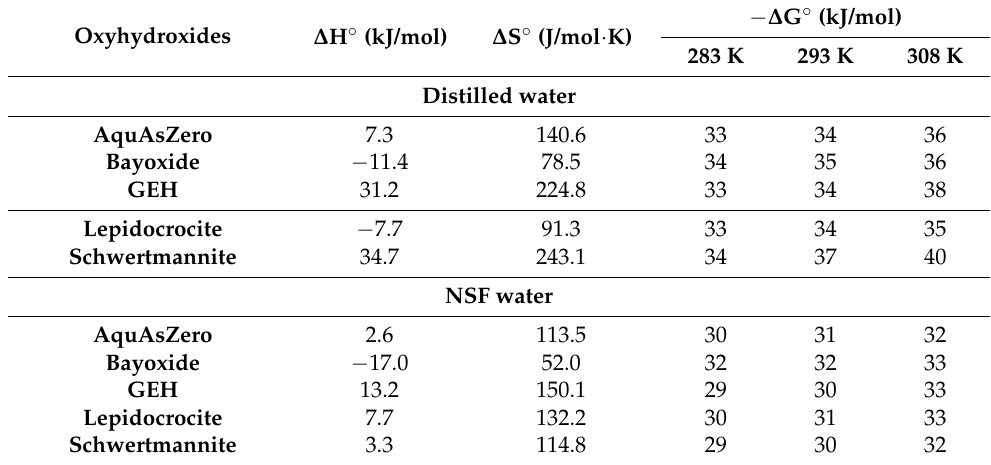
Table 3. Summary of the major thermodynamic parameters for all the five examined adsorbents.